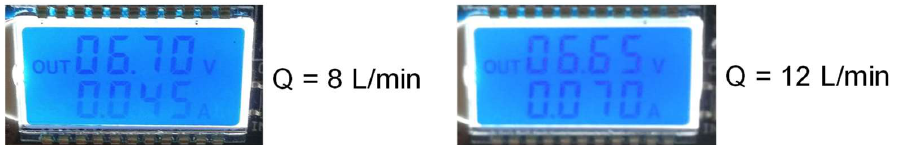
Figure 12. Operation of the energy harvesting unit, showing the display of the DC/DC converter for two values of the water flow rate Q in the pipe. The power manager sets an output voltage 6 V and selects the optimal battery charging current.